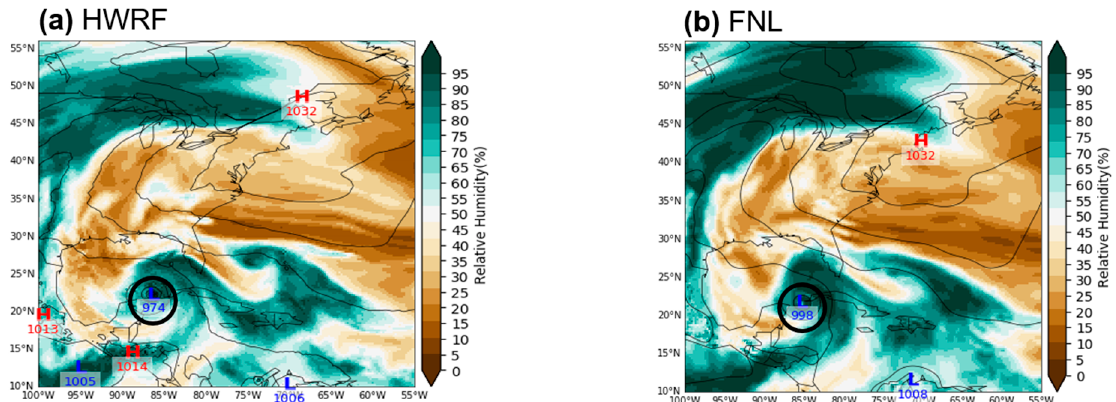
Figure 8. Mid-tropospheric (400–700 hPa average) relative humidity (RH, shaded) and mean sea level pressure (MSLP, contours and centers) in the environment near Hurricane Michael from ( a ) 48 h into an HWRF forecast initialized at 1800 UTC on 06 October 2018 and ( b ) FNL valid at 1800 UTC on 08 October 2018. The center position of Michael is identified by a black circle. RH is measured as a percentage, and MSLP has units of hPa.